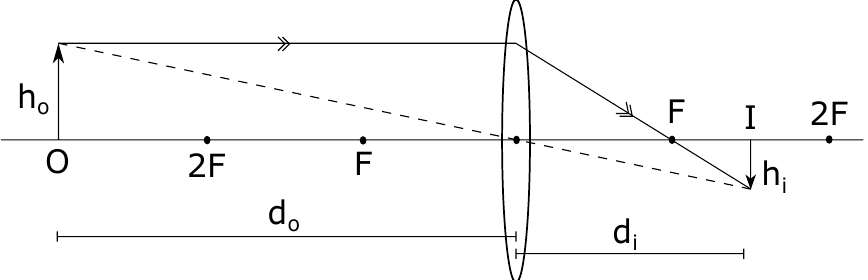
Figure 4. Refraction by convex lens when the object is beyond